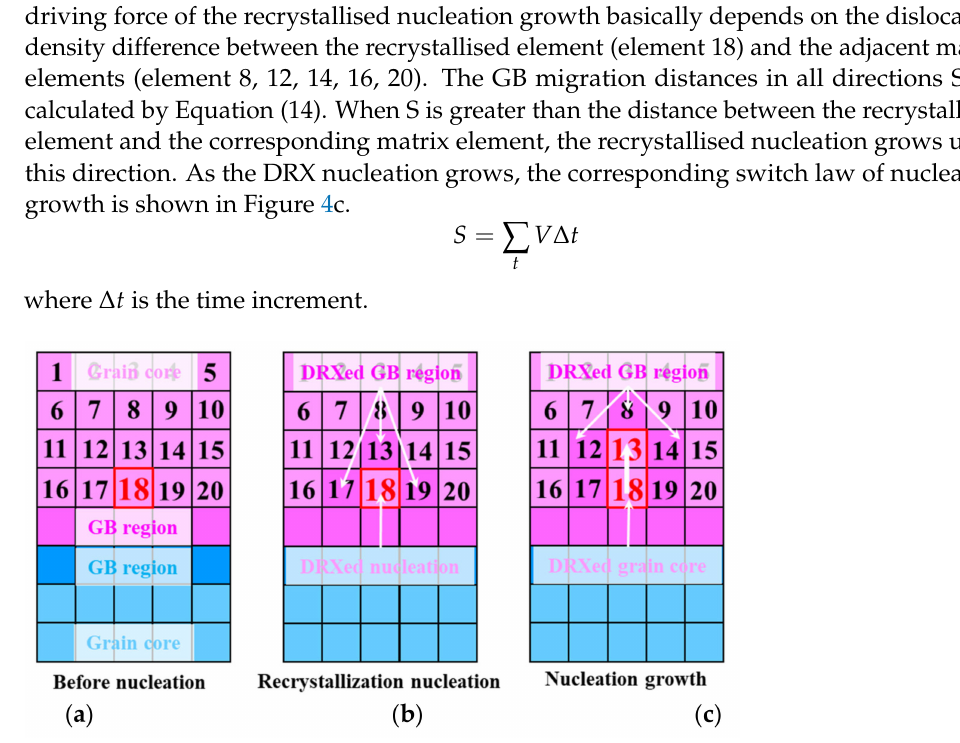
Figure 4. Switch law of recrystallised elements in CPFEM. ( a ) Before nucleation; ( b ) recrystallisation nucleation; ( c ) nucleation